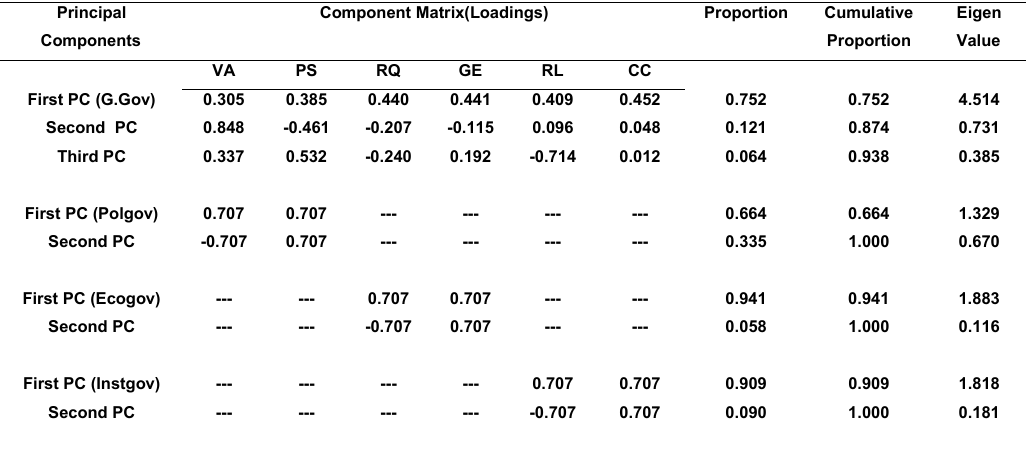
Table 4: Principal Component Analysis (PCA) for Governance